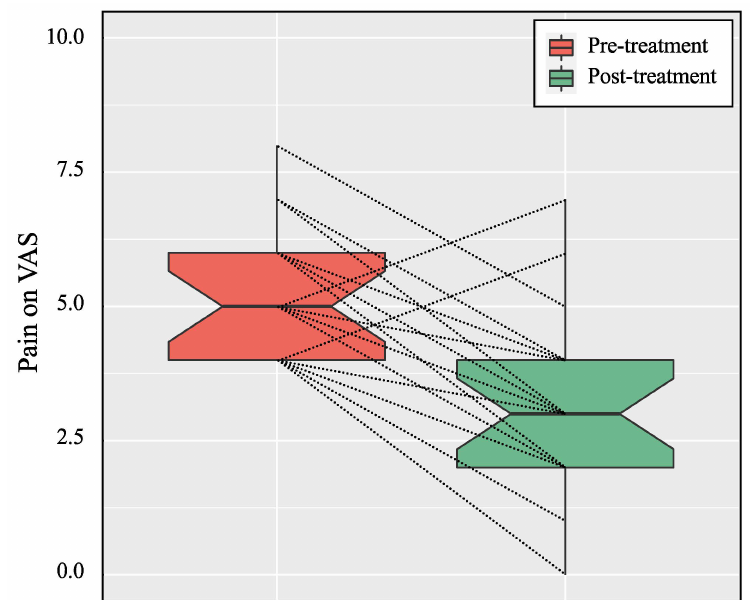
Figure 1. Pain on the visual analog scale (VAS) reported by the patients before and after the treatment of their nonspecific chronic low back pain (NSCLBP). The plots illustrate median values (bold lines), interquartile ranges (boxes), and 95% CIs (whiskers). Each dotted line corresponds to an individual patient change in pain on VAS between the pre- and post-treatments status.